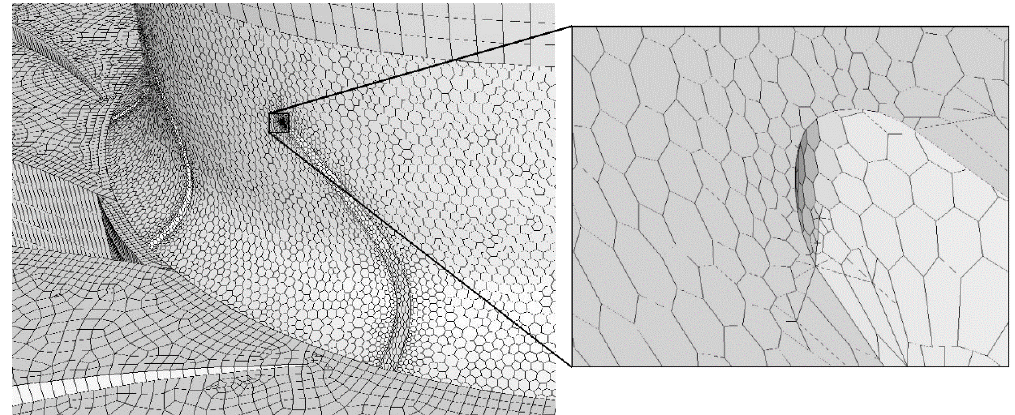
Figure 5. The polyhedral mesh generated on the rotor domain.